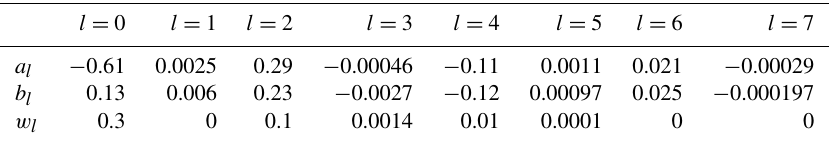
Table A1. Overview of the values coefficients a l , b l and w l